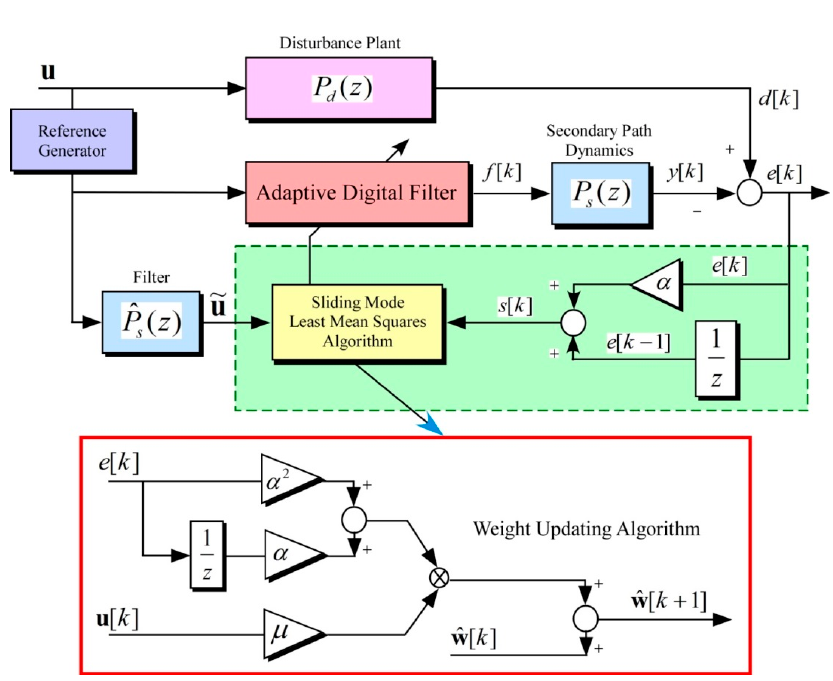
Figure 4. Proposed sliding mode least mean squares control (SM-LMS) method.